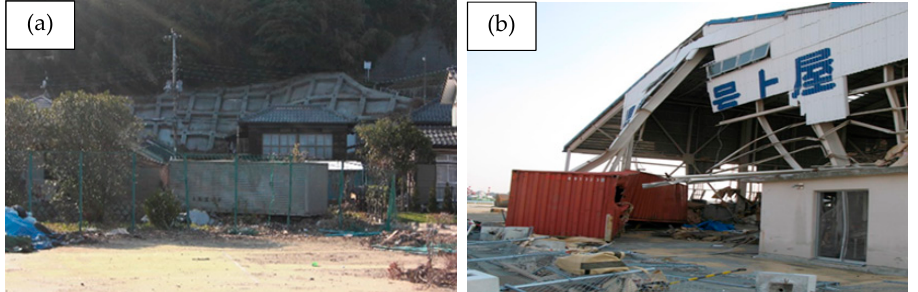
Figure 1. Damage from driftwood: ( a ) fallen trees collided against a hotel at Khao Lak in Thailand, and ( b ) some logs pierced the windows of a building at Ofunato in Japan.